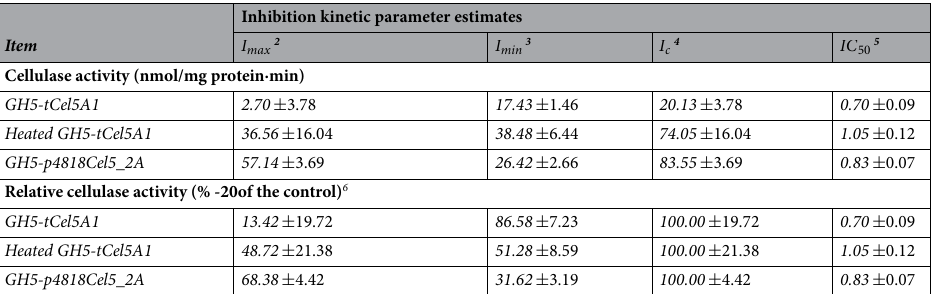
Table 2. Comparative summary of the Experiment-2 in vitro inhibition kinetics 1 of GH5-tCel5A1, the heat-treated GH5-tCel5A1 and GH5-p4818Cel5_2A under the gastric acidic pH of 3.5 and pepsin (274 U/ mL) obtained through the Eadie-Hofstee linear regression analyses. 1 Values are parameter estimates or means ± SE (n = 72) obtained through the Eadie-Hofstee regression linear analyses, representing the inhibition kinetic parameter estimates obtained from the three gastric acidic pH 3.5 and pepsin (274 U/mL) inhibition experiments with 4 replicates per time point in each experiment, as shown in Figs. 9, 10, 11. 2 I max is the maximal magnitude of inhibition in the cellulase activity (nmol/mg protein·min or % of the control, I c ; means ± SE, n = 12) calculated according to Eq. (2). 3 I min is the minimal residual cellulase activity (nmol/mg protein·min or % of the control I c ; parameter estimate ± SE, n = 72) under the combined gastric acidic pH 3.5 and pepsin (274 U/mL) inhibition conditions obtained from Eq. (1). 4 I c is the mean cellulase activity of the control group (nmol/mg protein·min or % of the control I c ; means ± SE, n = 12). 5 IC 50 is the incubation time (h, parameter estimate ± SE, n = 72) required to reach the half maximal inhibition of the cellulase activity. 6 Relative cellulase activity calculated as percentage (%, means ± SE, n = 12) of the control group ( I c ) measured at 0-min exposure to the combined gastric pH-3.5 and pepsin (274 U/mL)